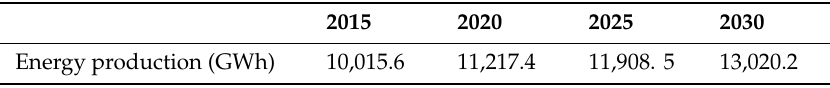
Table 2. Forecast of electricity production in a given area of GWh.